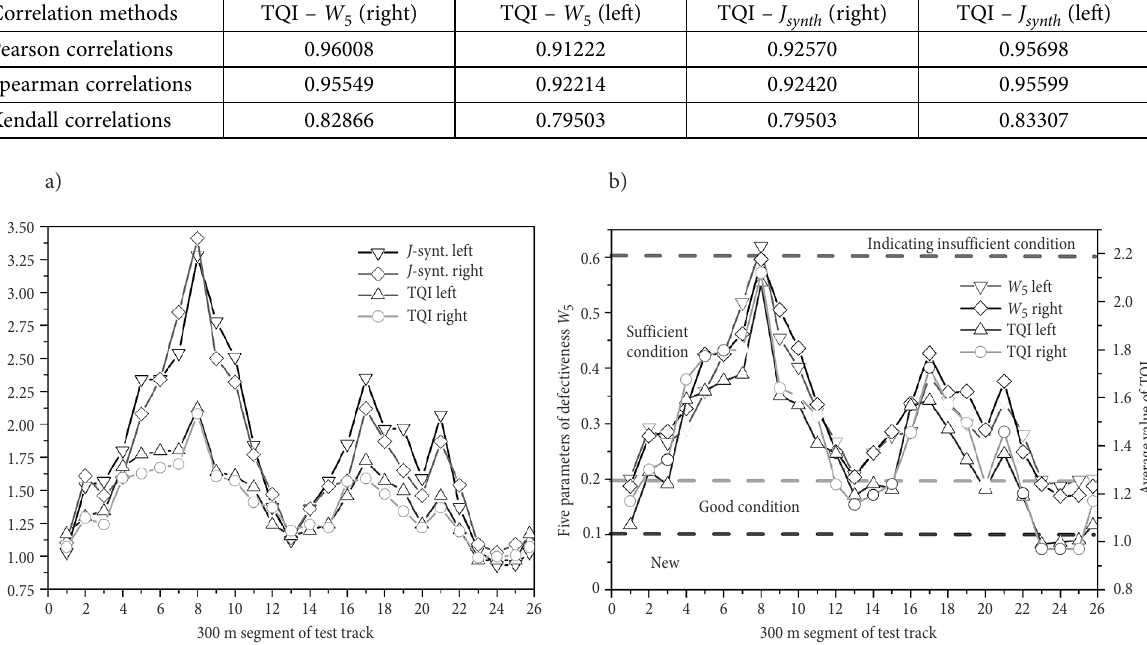
Fig. 7. Comparison of indicators of the quality of the track obtained from the test track in Żmigród (a) and classification of the TQI to quality of track (b)